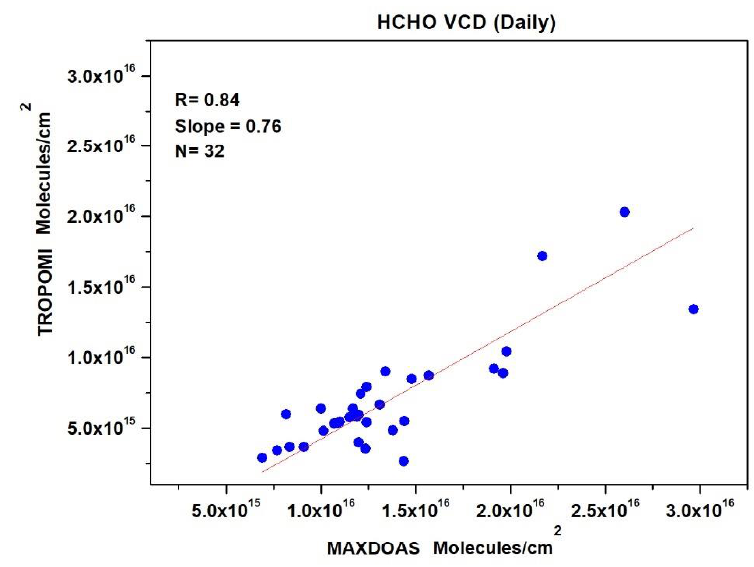
Figure 11. Scatter plot between MAX-DOAS and TROPOMI HCHO VCDs.